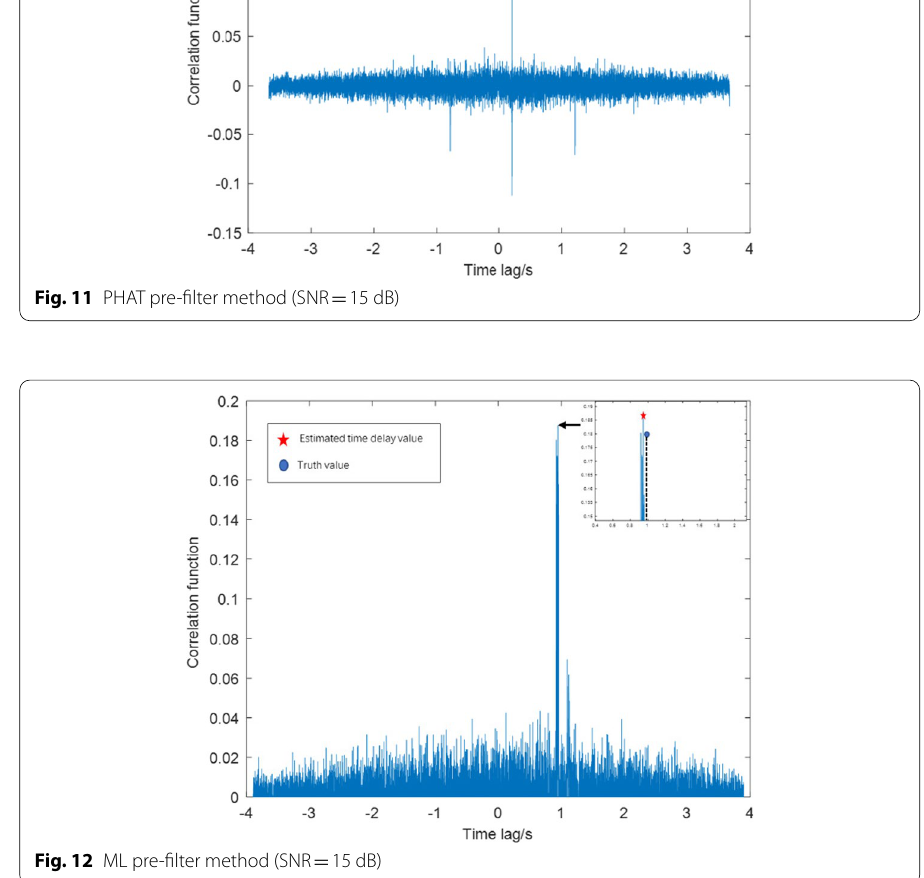
Fig. 12 ML pre-filter method (SNR